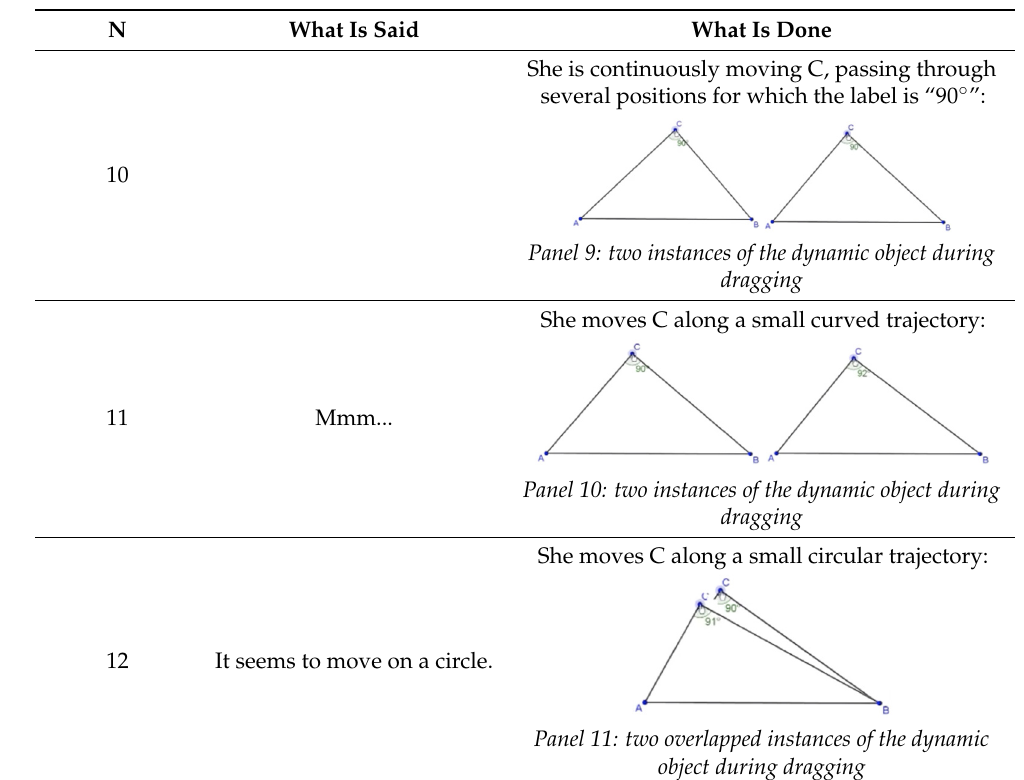
Table 7. Excerpt 4 from Ilaria’s DGE exploration.